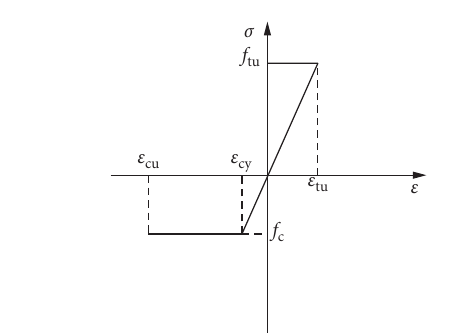
Figure 1: Stress-strain relationships of glulam